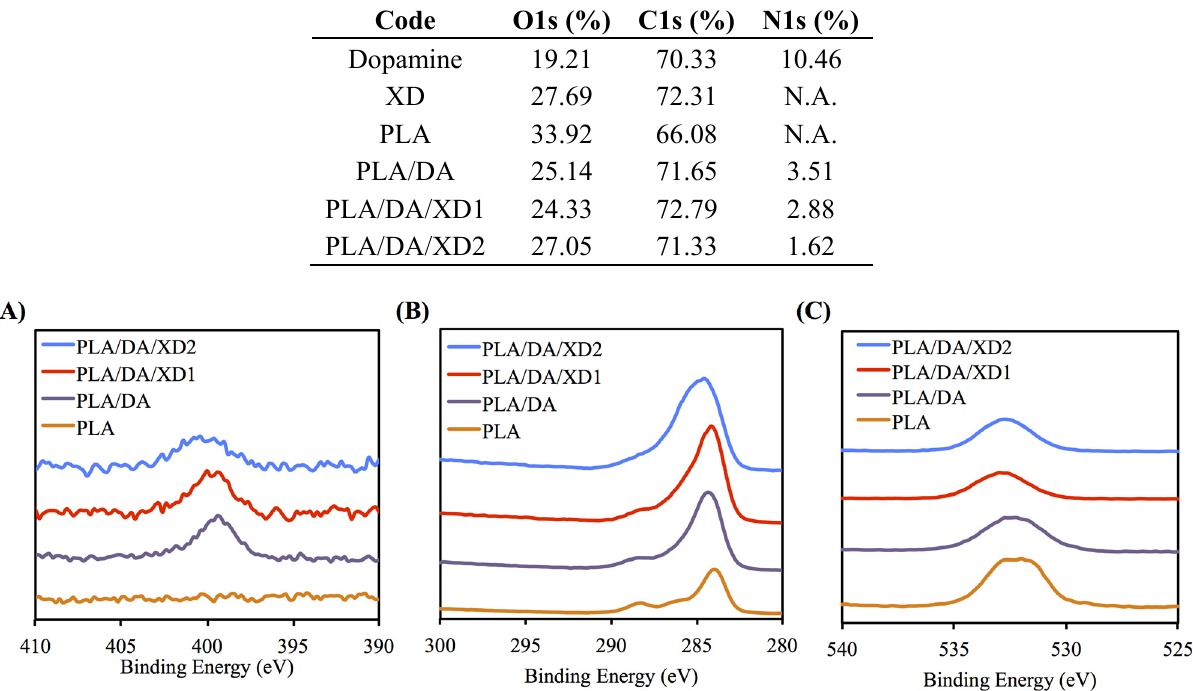
Figure 2. XPS ( A ) N1s; ( B ) C1s; and ( C ) O1s high-resolution spectra obtained on PLA scaffolds after coating with